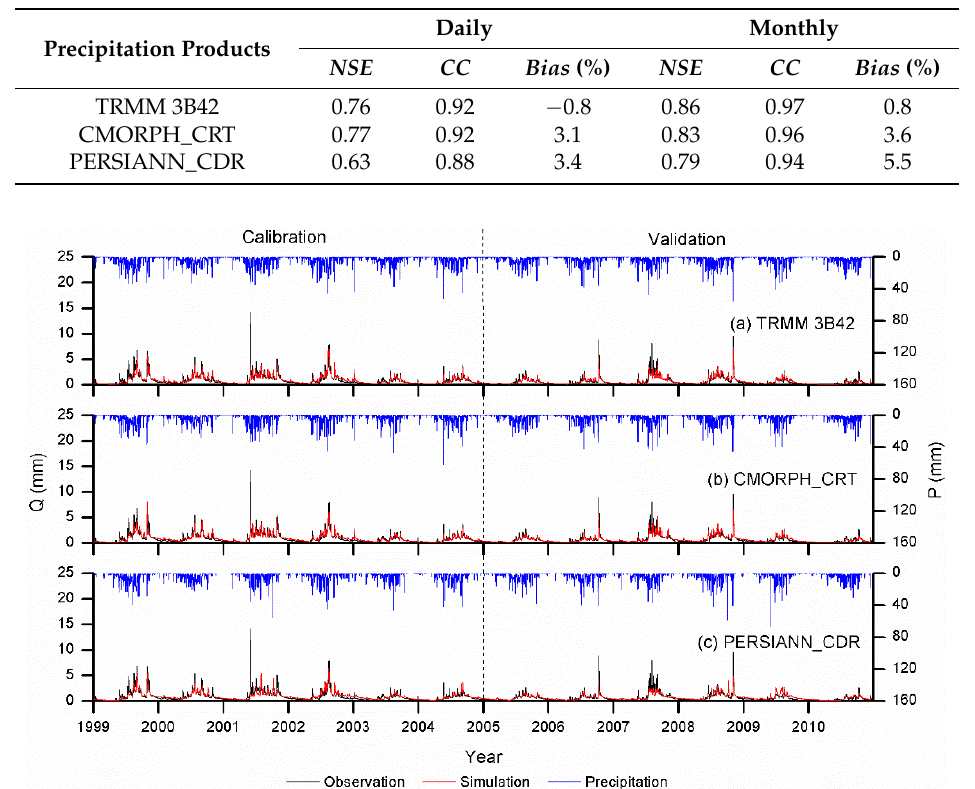
Figure 10. Daily discharge flow duration curves (FDCs) for observations, TRMM 3B42 simulation, CMORPH_CRT simulation, and PERSIANN_CDR simulation under Scenario II.